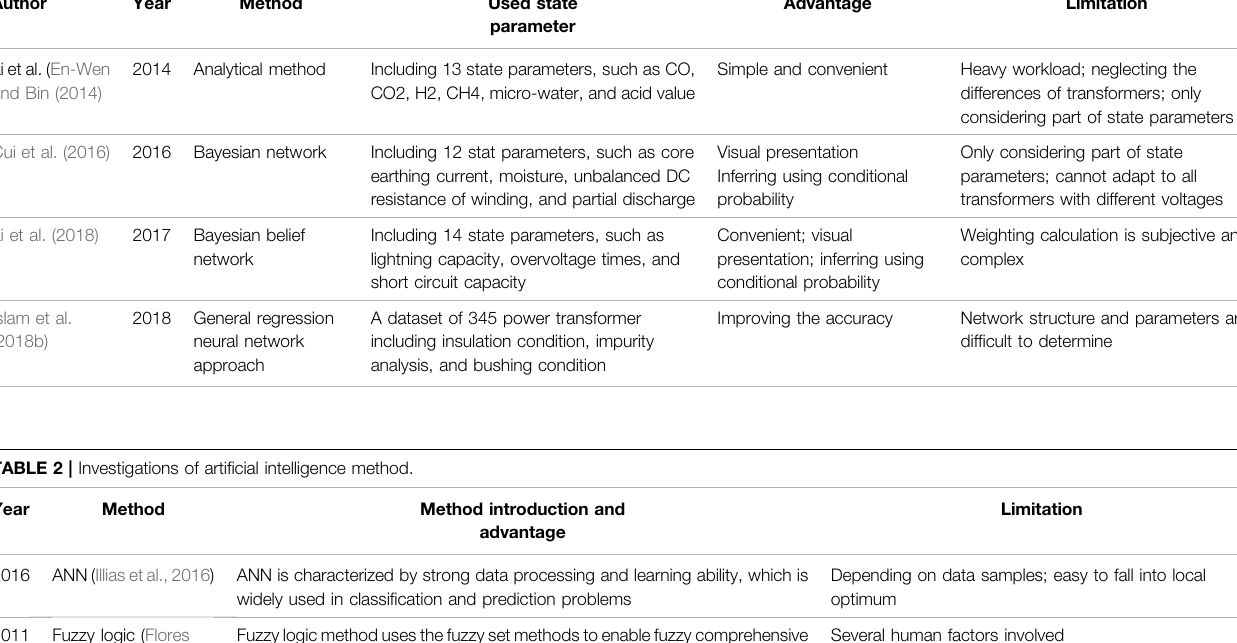
TABLE 1 | Investigations of the information fusion method.